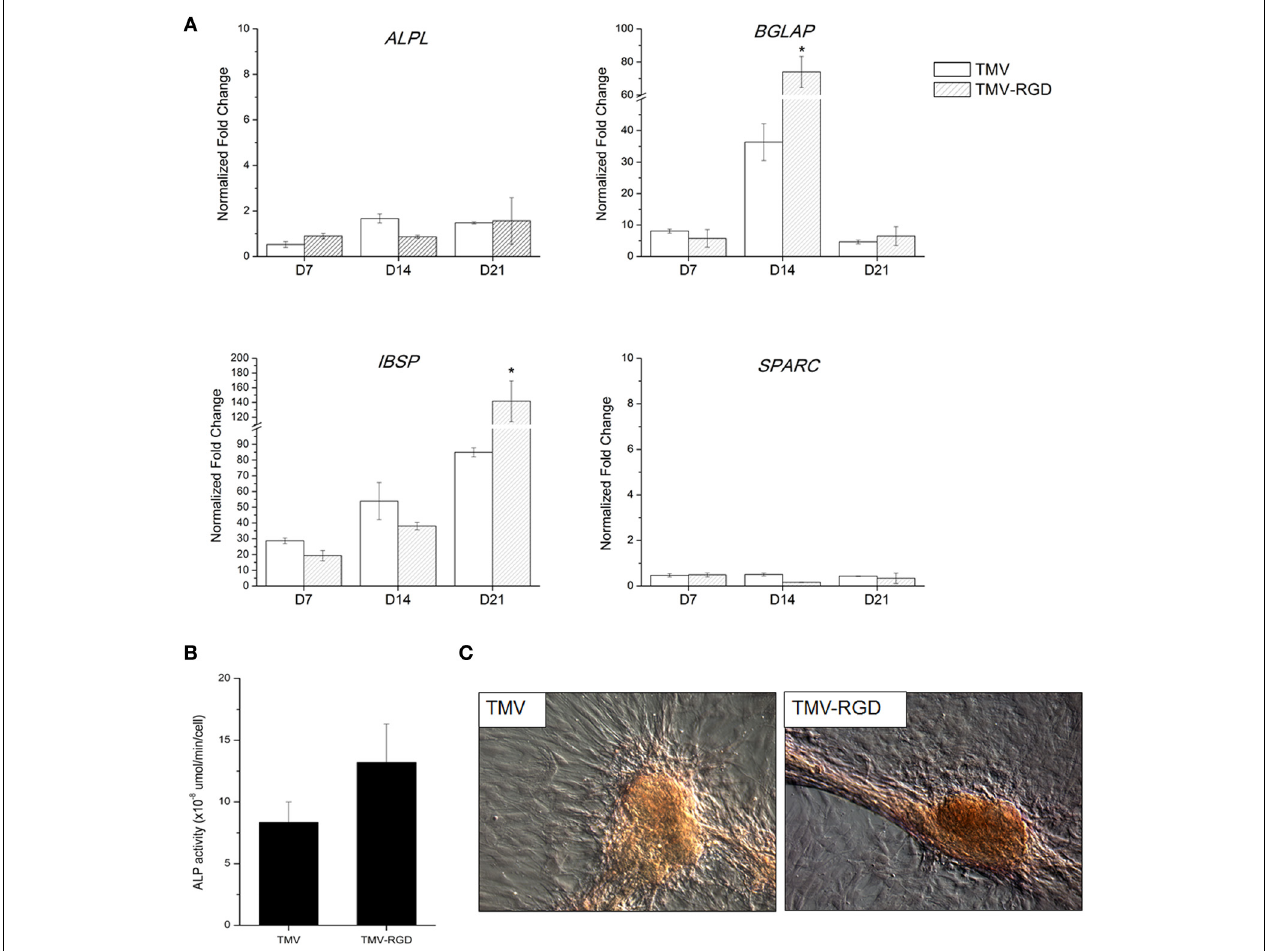
∗ p < 0 . 05. (B) Alkaline phosphatase activity of cells on TMV and TMV-RGD at day 14. BMSCs on TMV-RGD substrates have a slight increase in enzyme activity compared to cells on TMV. However, the difference is not statistically significant. (C) Optical images of Alizarin red S staining of cells cultured for 14 days on TMV or TMV-RGD substrate showing calcium deposition in red